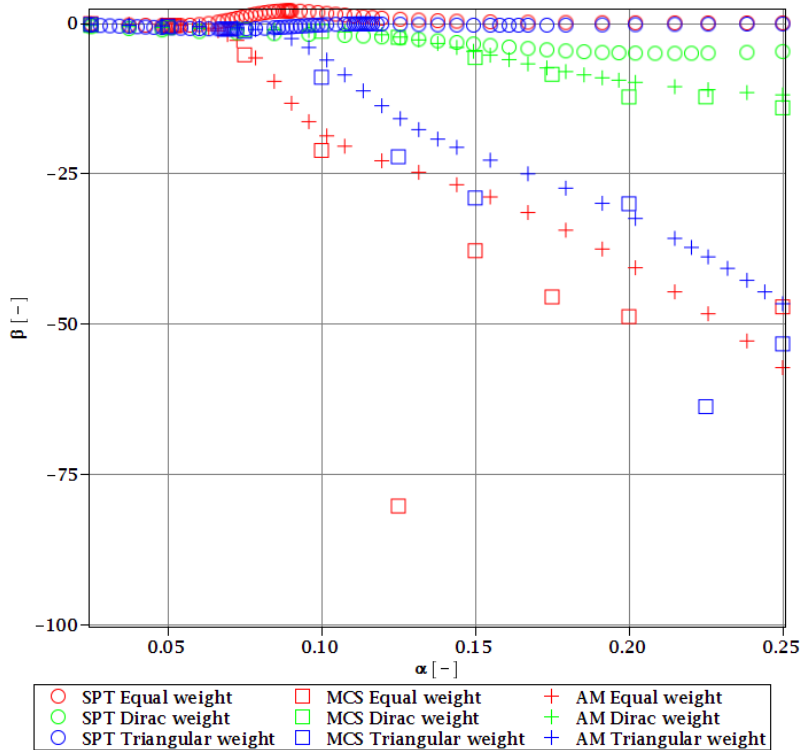
Figure 10. The skewness of the critical load for different types of weights.